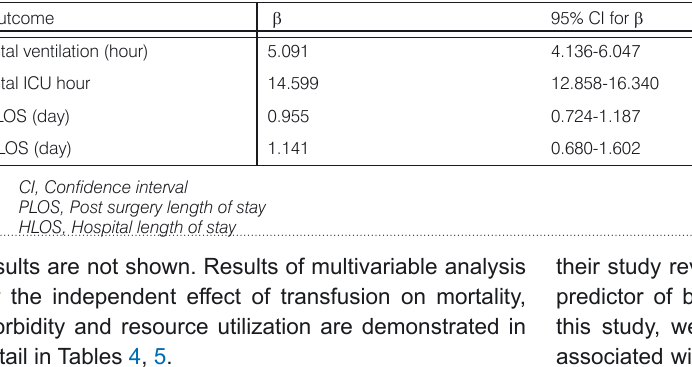
Table 5. Blood transfusion effect on resource utilization in Multivariable linear regression analysis adjusted for confounders.